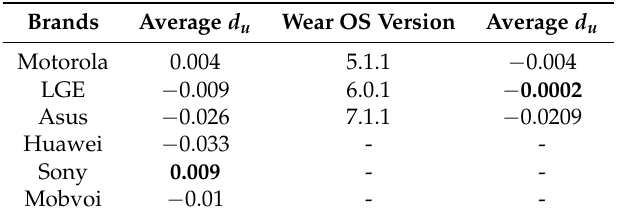
Table 10. Average of d u score based on the brands and Android